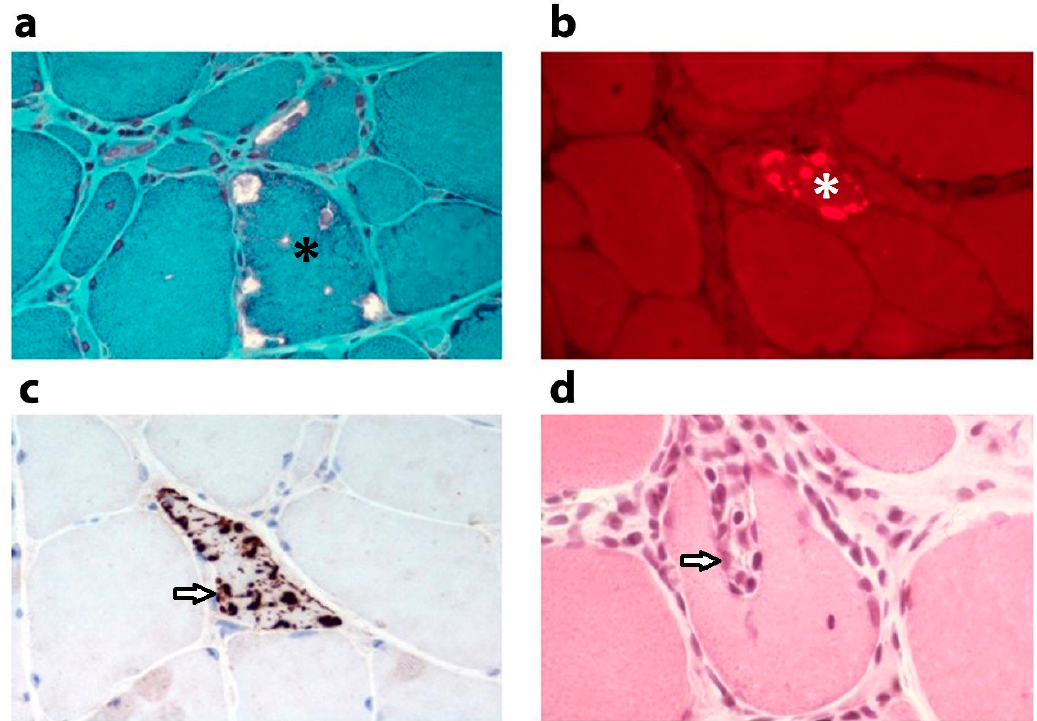
Figure 1. Histological features of sporadic inclusion body myositis muscle. Histological characteristics in a quadriceps muscle biopsy from a male 73 years old patient diagnosed with sporadic inclusion body myositis. ( a ) Modified Gomori trichrome stain reveals several vacuoles in a muscle fibre (asterisk). ( b ) Congo red stain detected under fluorescent light visualizes a muscle fibre with inclusions containing β -amyloid (asterisk). ( c ) Immunostaining of the ubiquitin-binding scaffold protein and autophagy receptor p62/sequestosome1 (3’-Diaminobenzidine stain, brown) shows sarcoplasmic p62-immunoreactive aggregates in a muscle fibre (arrow). ( d ) Haematoxylin and eosin stain showing autoaggressive inflammatory cells targeting a nonnecrotic muscle fibre (arrow). Magnification ×785 before reduction.